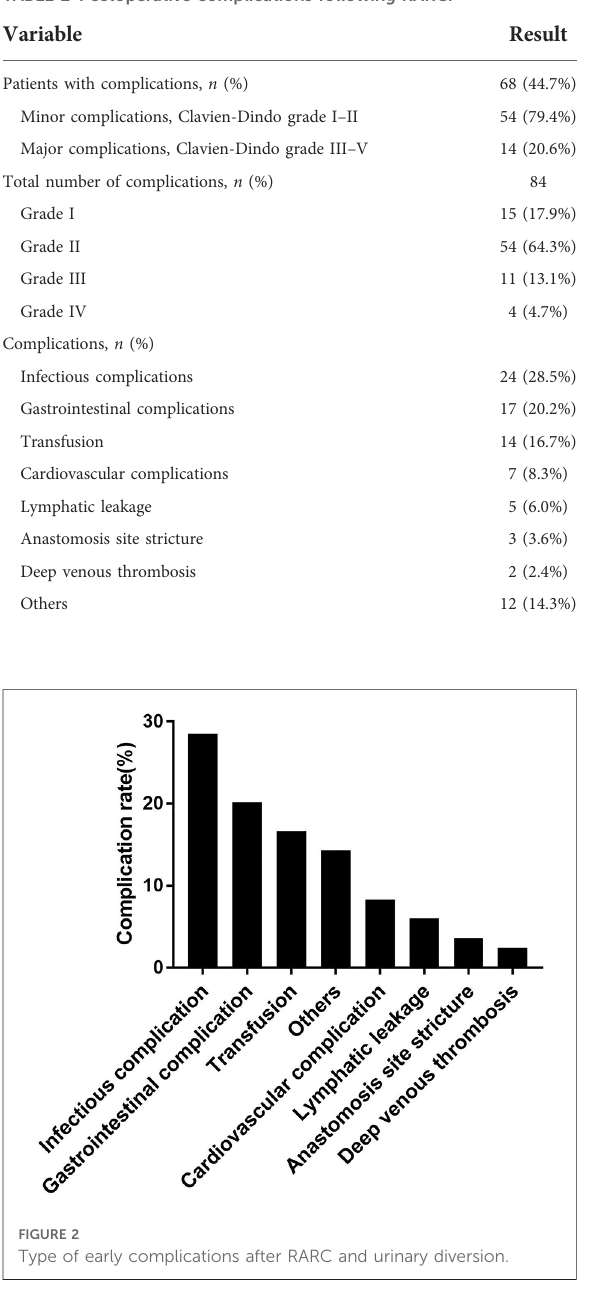
TABLE 2 Postoperative complications following RARC.